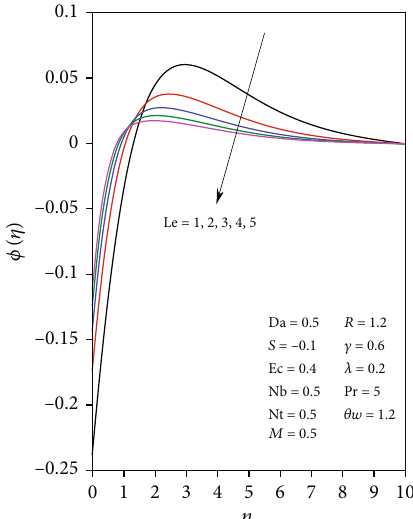
Figure 22: Concentration of nanoparticle pro fi le for di ff erent values of Nb